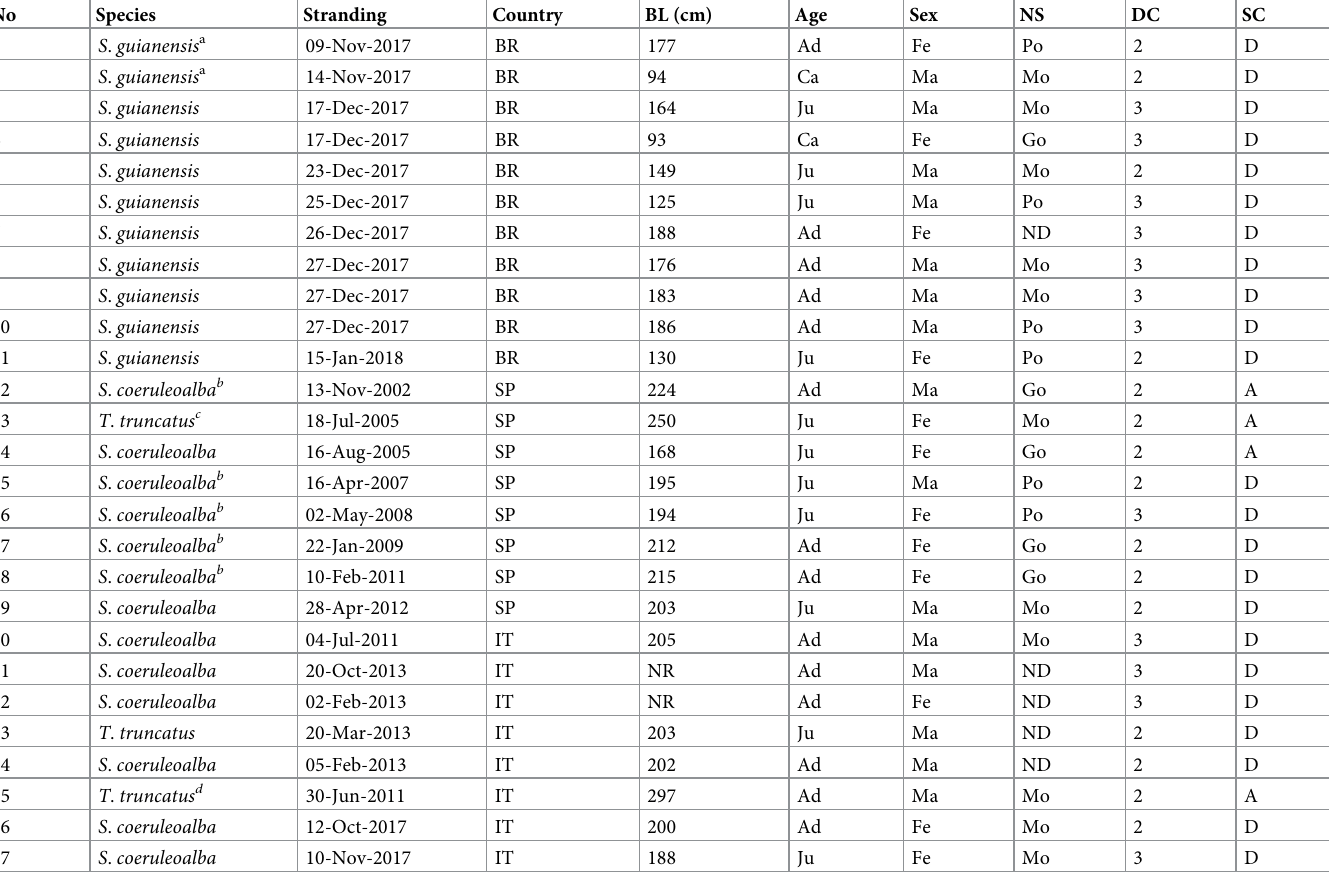
Table 1. Epidemiologic and biologic data on Guiana dolphins ( Sotalia guianensis ), striped dolphins ( Stenella coeruleoalba ), and bottlenose dolphins ( Tursiops trun- catus ). All animals were cetacean morbillivirus (CeMV) positive by conventional and/or real time